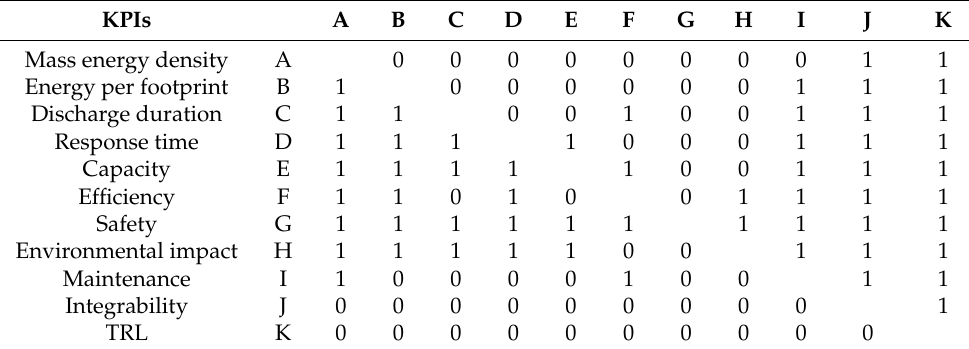
Table A2. KPI comparison matrix (Scenario B).